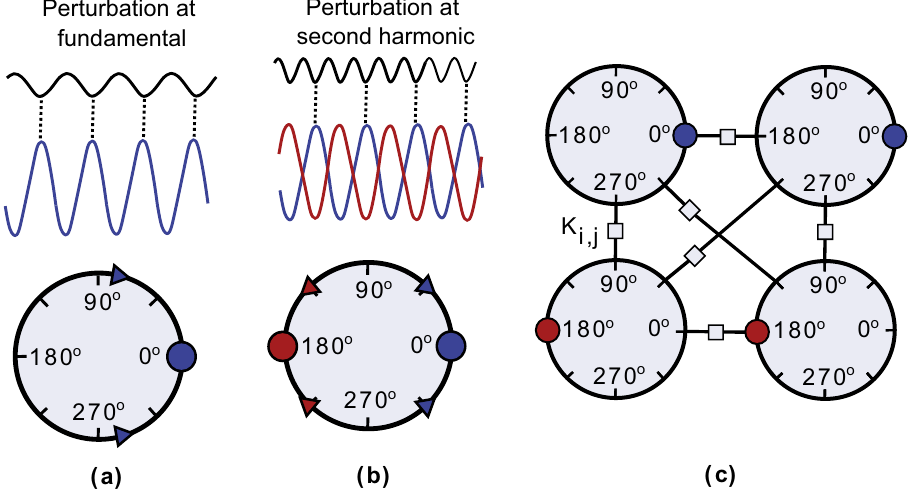
Figure 1. Graphical illustration of ( a ) fundamental injection locking, ( b ) SHIL and ( c ) a network of four coupled SHIL